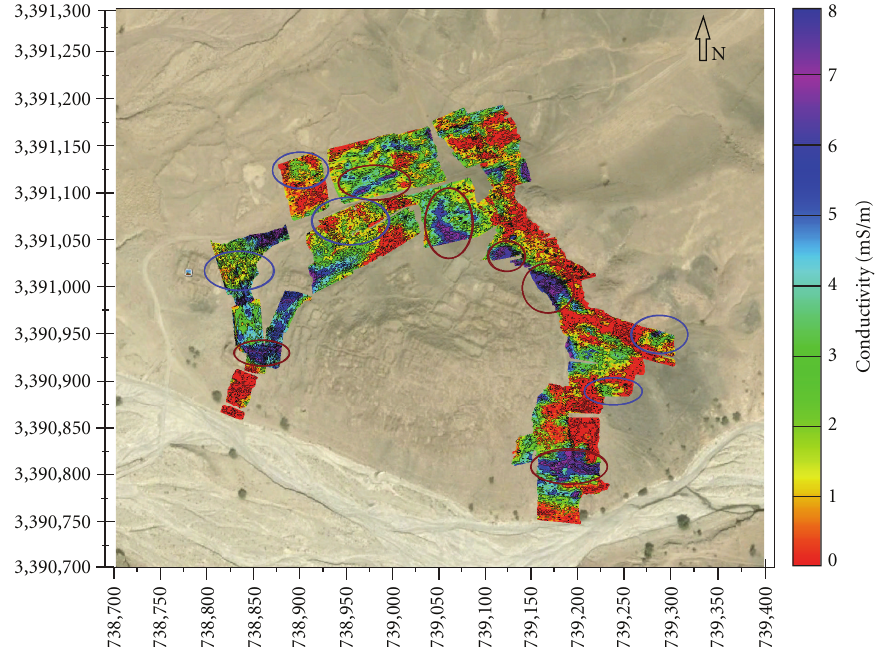
Figure 3: EMI data acquired at Khirbat Faynan. While numerous ancient walls can be seen on the surface of this site with Google Earth, the geophysics survey aimed at identifying subsurface features suitable for excavation. Blue color ellipses show interesting areas of low conductivity. Brown color ellipses indicate areas of high conductivity that might be related to past human activity. The site measures approximately 270 × 640